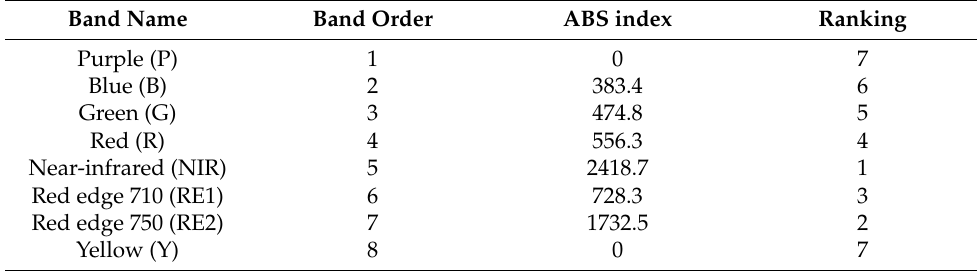
Table 5. ABS index and ranking of each band of GF-6 WFV